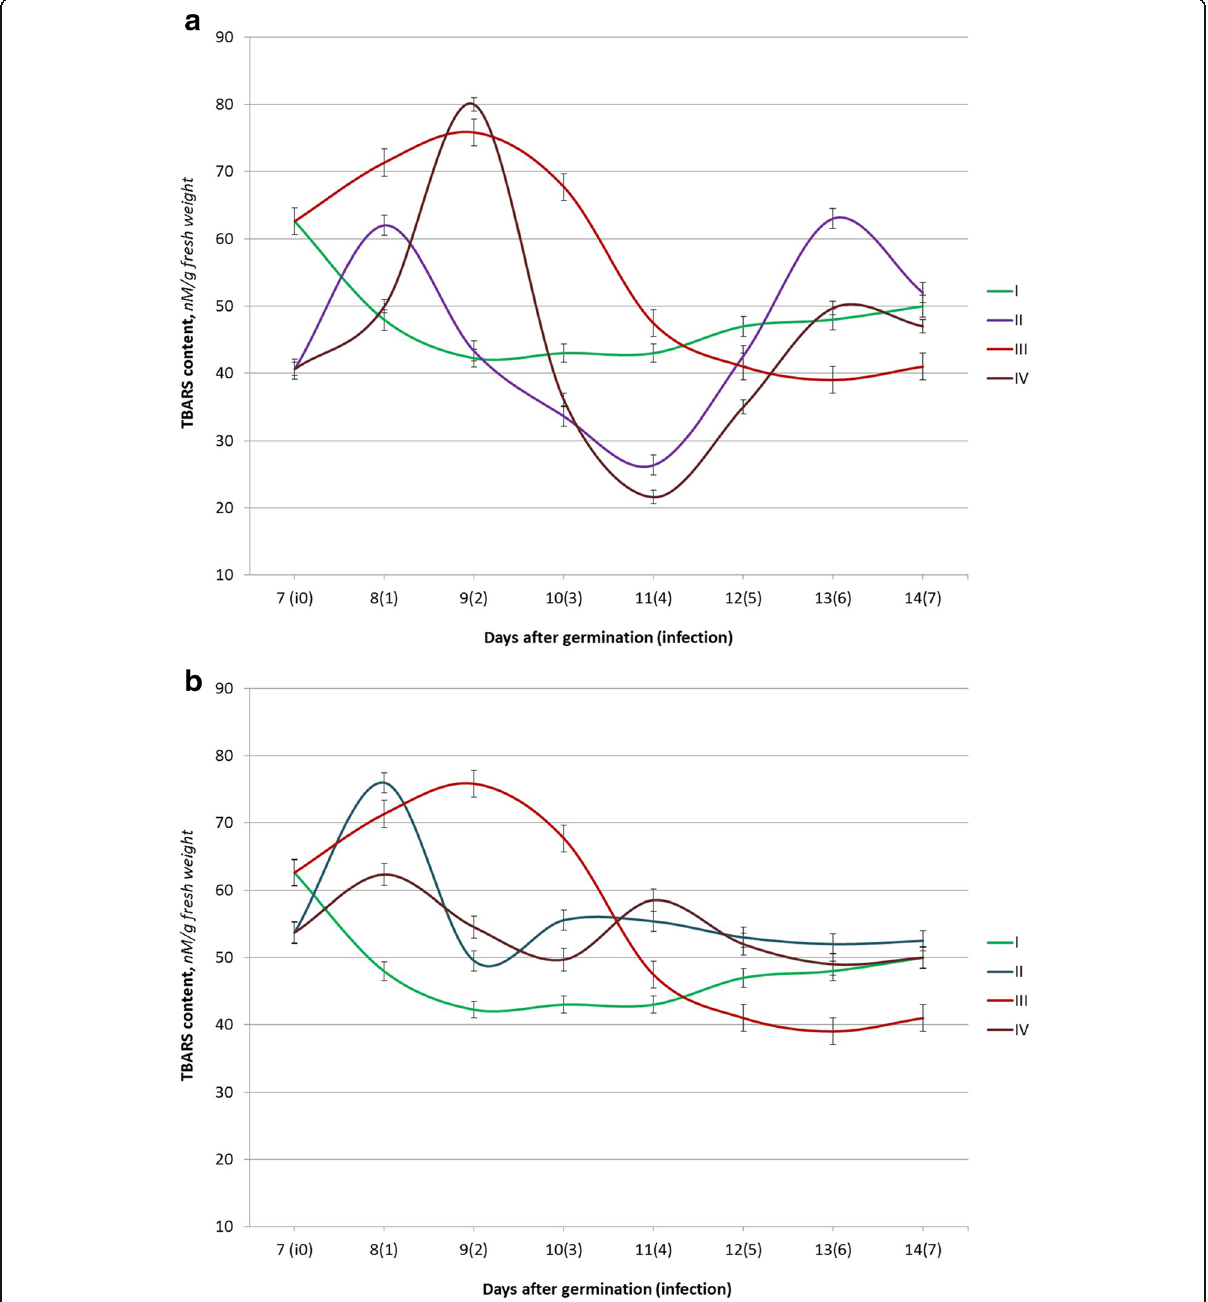
Fig. 1 The TBARS content in seedlings of winter wheat (the Myronivska 808 variety) under the action of Ag ( a ) or Cu ( b ) nanoparticle solutions and P. herpotrichoides infection: I control plants (w/o infection); II seed treatments with Ag ( a ) or Cu ( b ) nanoparticle solution; III P. herpotrichoides infection; IV P. herpotrichoides infection + treatment with Ag ( a ) or Cu ( b ) nanoparticle